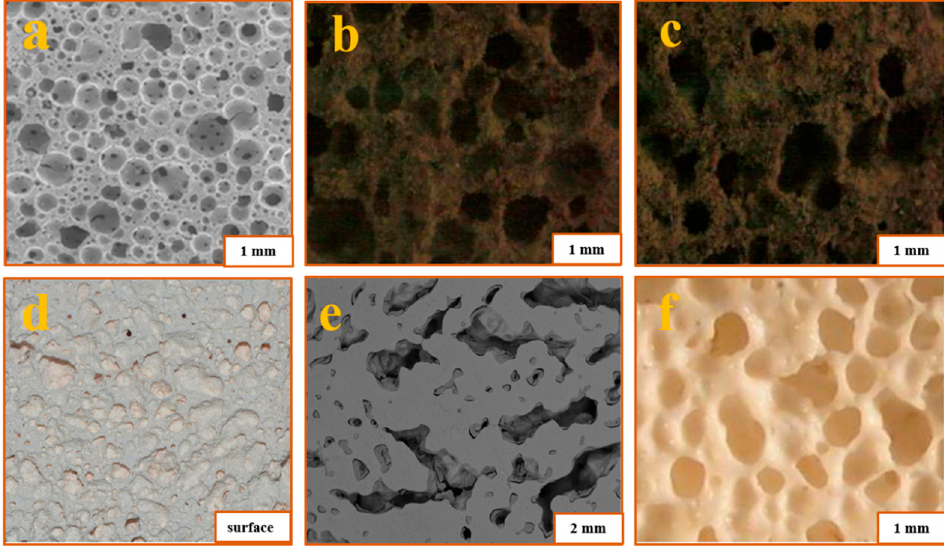
Figure 12. ( a ) SEM image of 15.7 mass% surfactant samples. ( b ) Image of 10 mass% Fe samples. ( c ) Image of 10 mass% Al samples. ( d ) Surface of H 2 O 2 samples. ( e ) BSE image of limestone samples. ( f ) 0.20 mass% Al samples calcined at 1250 °C for 1 h [51,63,71,86,87]. Table 6. The performance parameters of ASP geopolymer porous foams prepared with different foaming